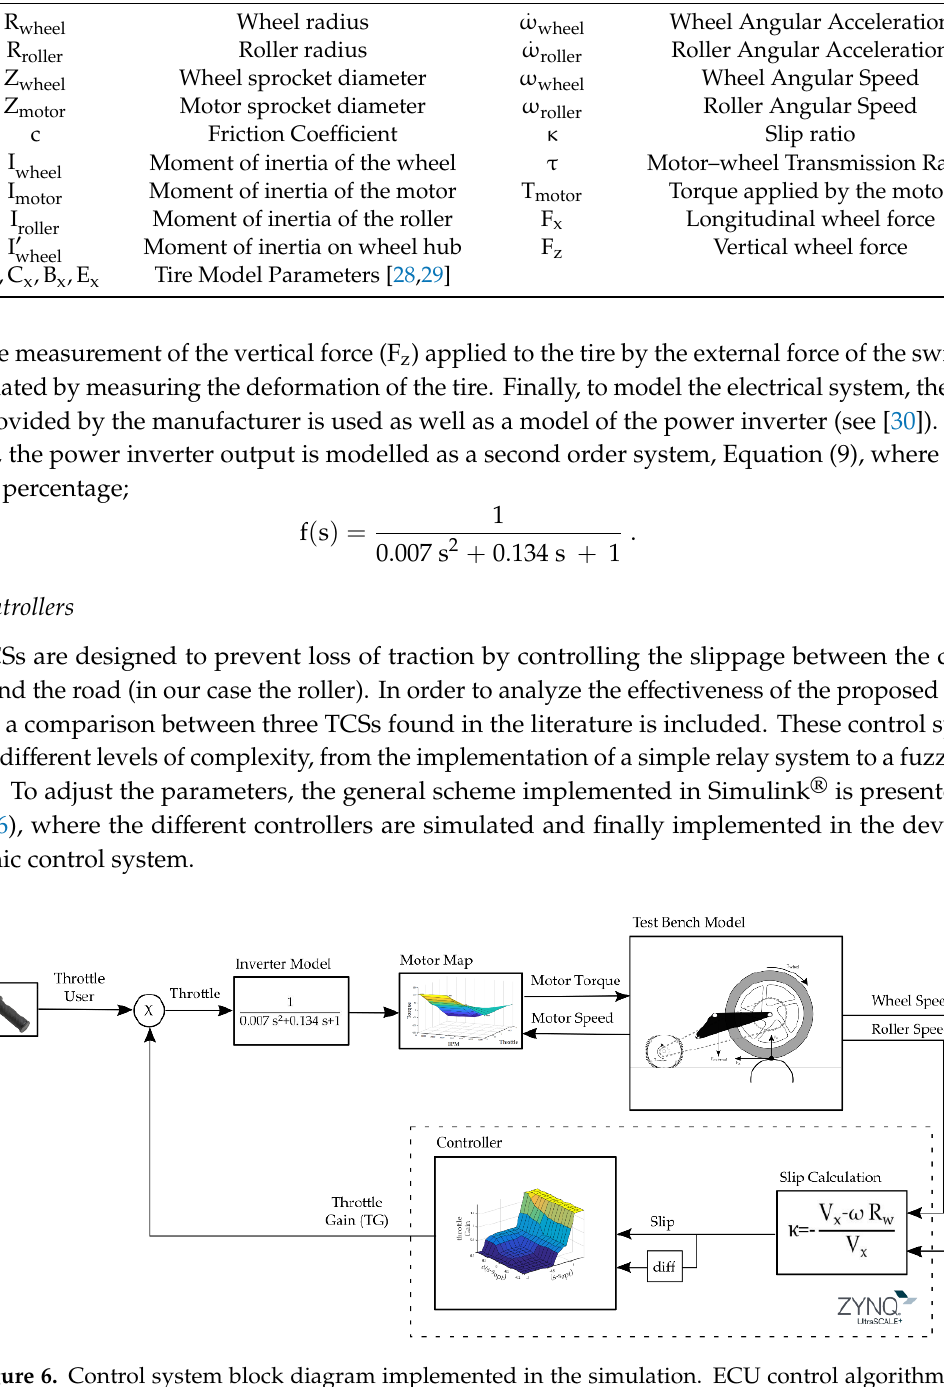
Figure 6. Control system block diagram implemented in the simulation. ECU control algorithm is represented inside the dashed box.